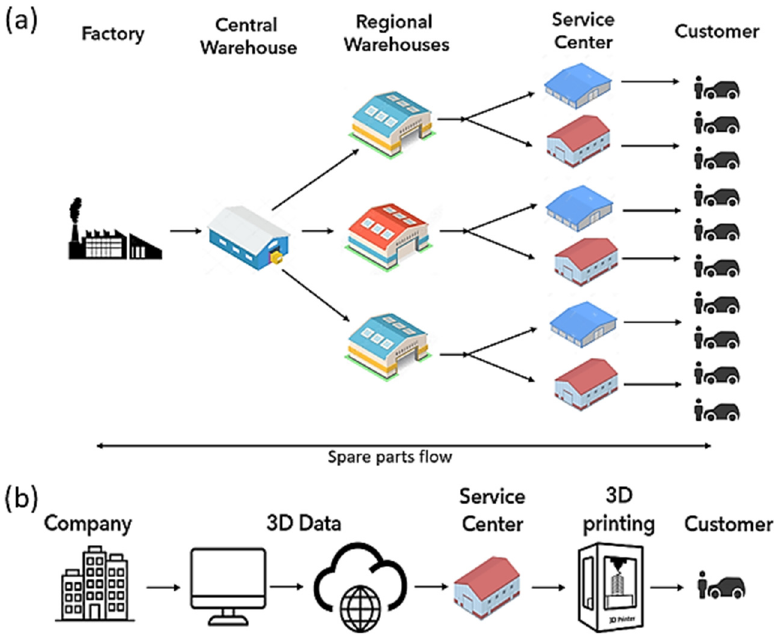
Figure 1. ( a ) Spare part flow chain structure, ( b ) Digital spare parts management.